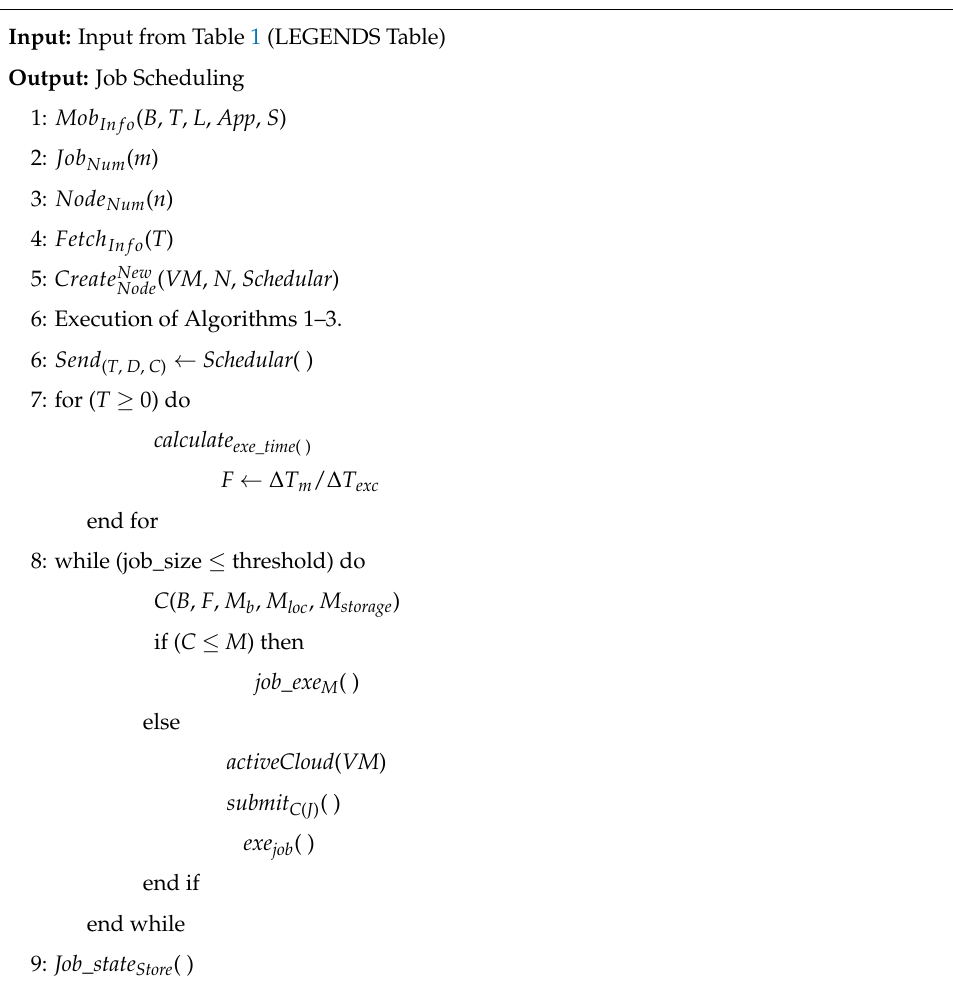
Algorithm 4. Task Scheduling